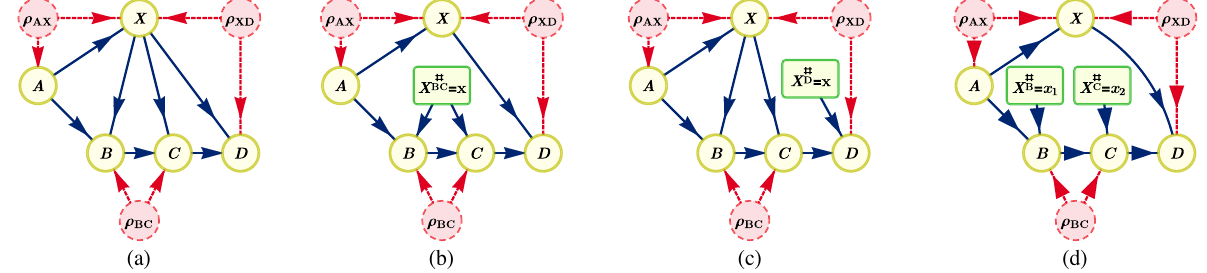
FIG. 17. A survey of hypothetical interventions on edges emanating from the node X in a pedagogically motivated example causal structure. (a) The example causal structure without any interventions. (b) The do-conditional P ð ABCDX do f X # ¼ x # g → f BC gÞ where both edges X → B and X → C are intervened upon with the same value of X being sent down both intervened edges. This do-conditional is identifiable and has a unique value computable from observational statistics alone, namely, P ð ABCDX ¼ x do f X # ¼ x # g → f BC gÞ¼ P ð ABCDX ¼ x Þ P ð BC j A; X ¼ x # Þ =P ð BC j A; X ¼ x Þ . where the edge X → D is intervened upon. This do-conditional is nonidentifiable (as X and D share a latent parent) and, hence, is interesting to estimate using quantum inflation. (d) The do-conditional P ð ABCDX do f X # ¼ x # 1 g → B; f X # ¼ x # 2 g → C Þ where the pair of edges X → B and X → C are intervened upon with a different value of X being sent down the two intervened edges. This do-conditional is nonidentifiable (as B and C share a latent parent) and, hence, is interesting to estimate using quantum inflation.